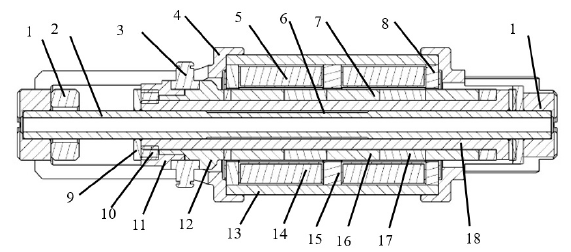
Fig. 1. 2D engineering drawing of the voice coil linear motor.